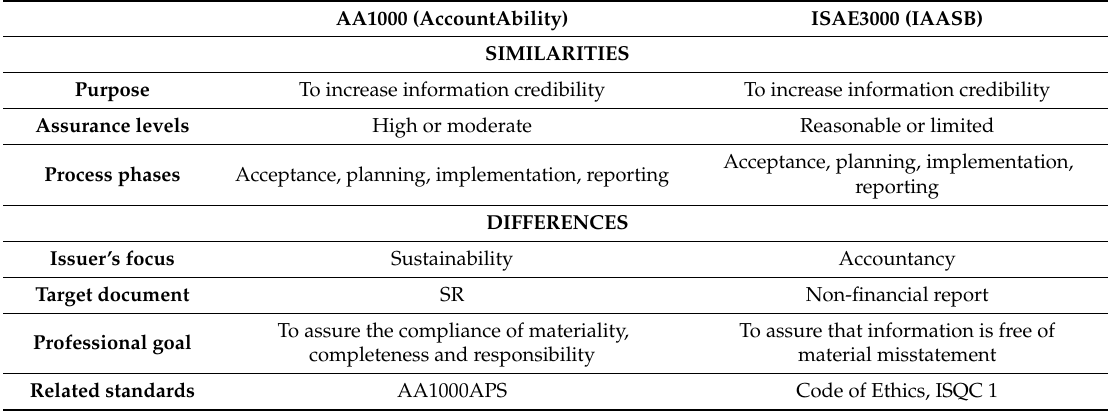
Table 1. Comparison of international assurance